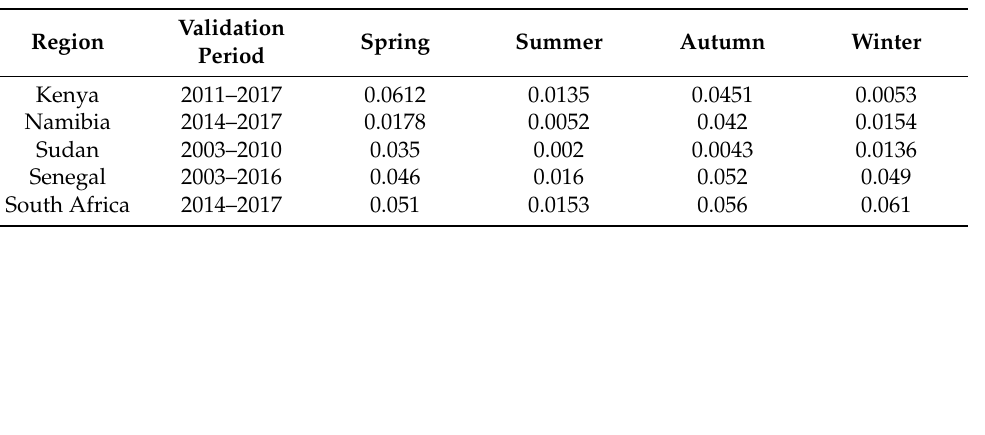
Table 4. The analysis of the seasonal ground observations in the five